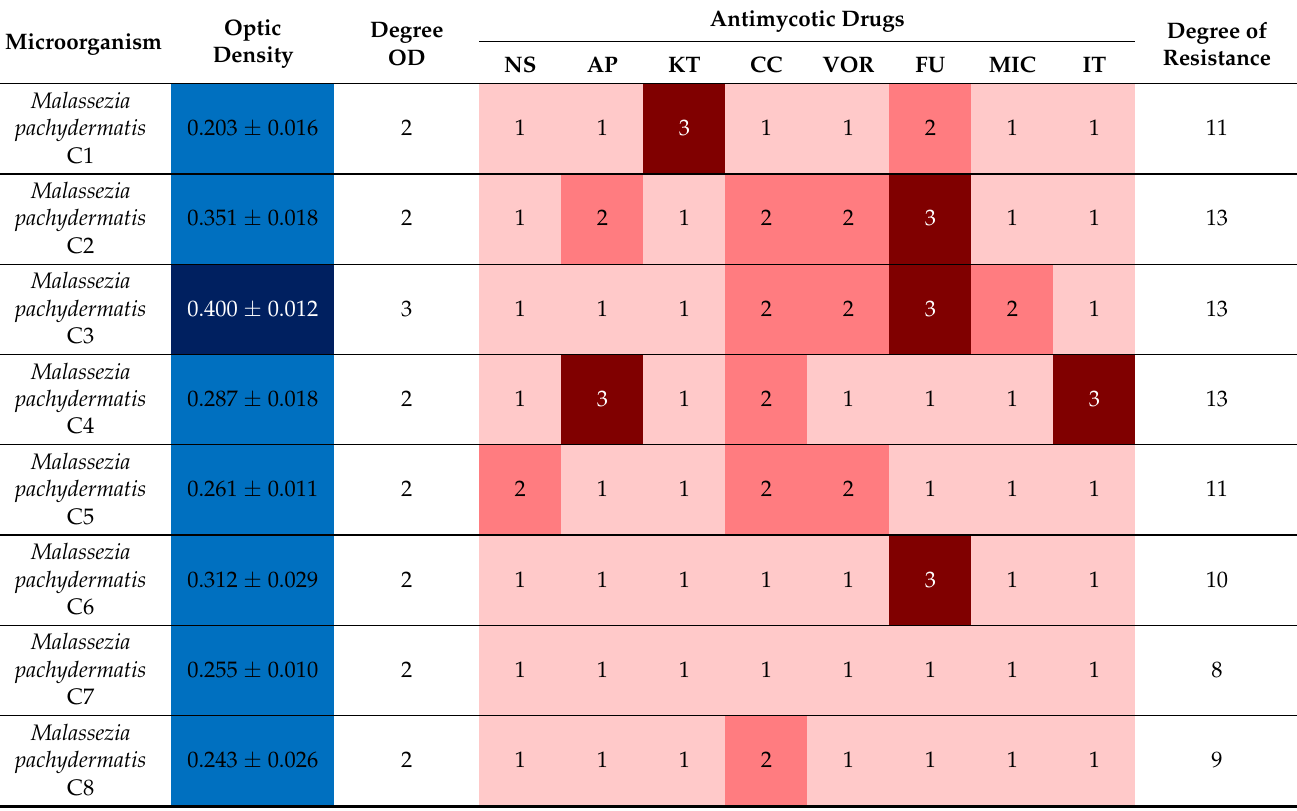
Table 2. Determination of the biofilm formation intensity of Malassezia pachydermatis stains by optic density and their susceptibility to antimycotics. The richer the color, the higher the corresponding